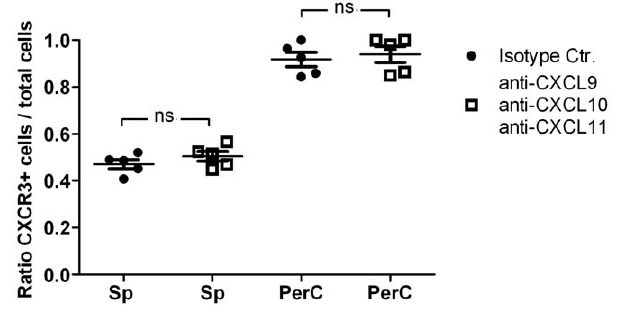
Figure 4. Neutralization of CXCR3 ligands does not block preferential migration of CXCR3 + CD4 + T cells to the PerC. CXCR3 + and CXCR3 2 CD4 + T cells isolated from donor animals were differentially labeled with CFSE or CMTMR, and mixtures containing equal numbers of cells were injected intravenously into naı¨ve recipients pretreated with a cocktail of anti-CXCL9, anti-CXCL10 and anti-CXCL11 antibody or an appropriate isotype control. Eighteen hours after transfer, the ratio of transferred CXCR3 + cells to total transferred cells was determined in different organs by flow cytometry. Dots represent the ratio for individual animals. Horizontal lines indicate the mean for the group, and error bars correspond to the SEM. n.s. – not significant. Sp, spleen; PerC, peritoneal cavity.